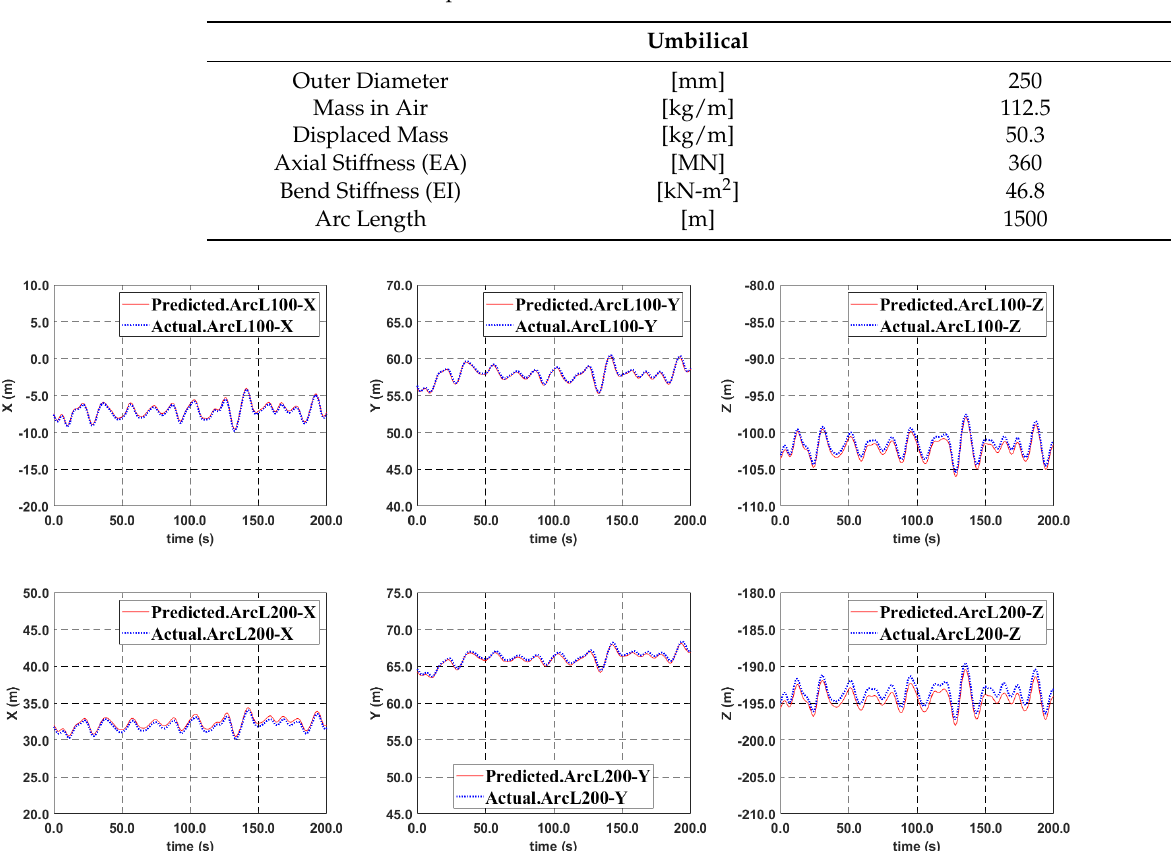
Figure A5. Structural-Health Monitoring Performance Comparison Near Touch Down Zone (= Arc Length 1200 – 1300 m) and near mid-length (700 m) between DA and FTO Approaches: 100-yr Storm, WD1000, Sensors at 0 m, 100 m, 200 m Arc Length Only, Umbilical.